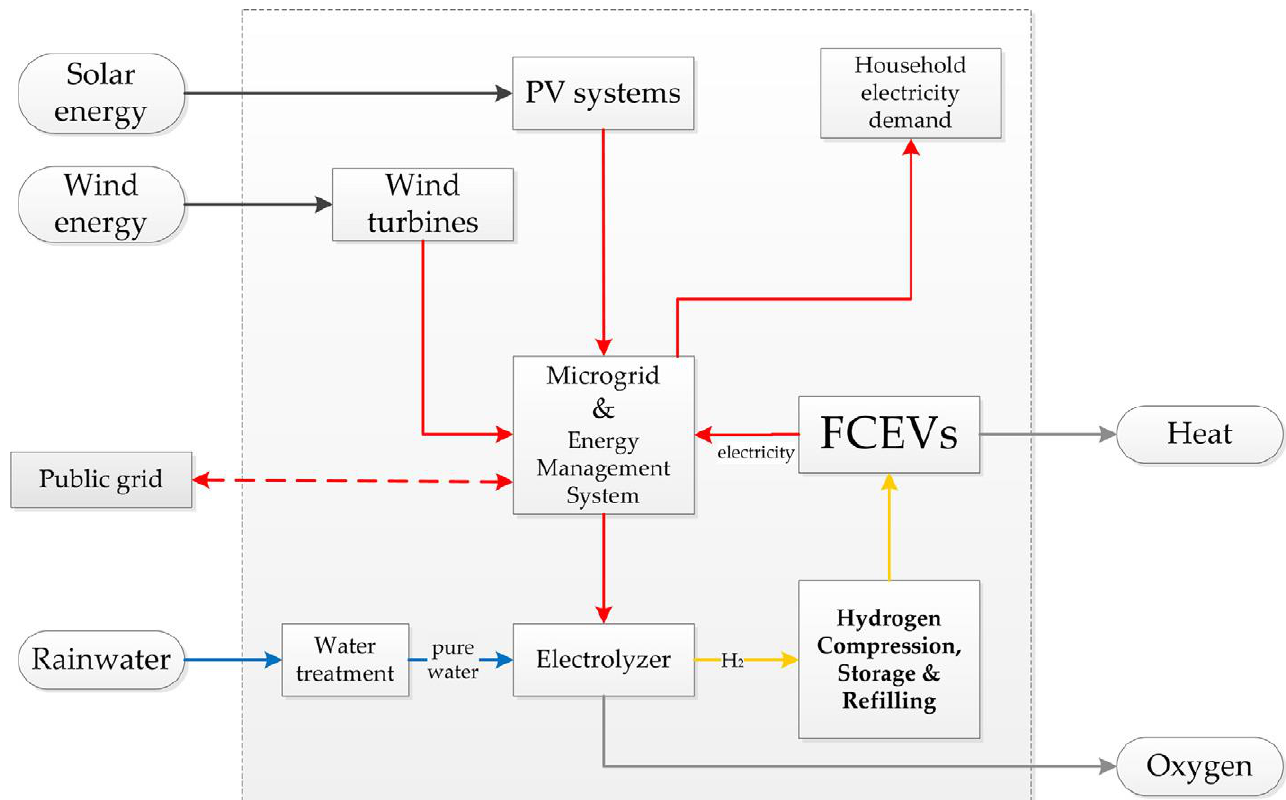
Figure 3. Schematic representation of a “car as power plant” microgrid system. Reprinted with permission from Ref. [26]. 2017, Elsevier.